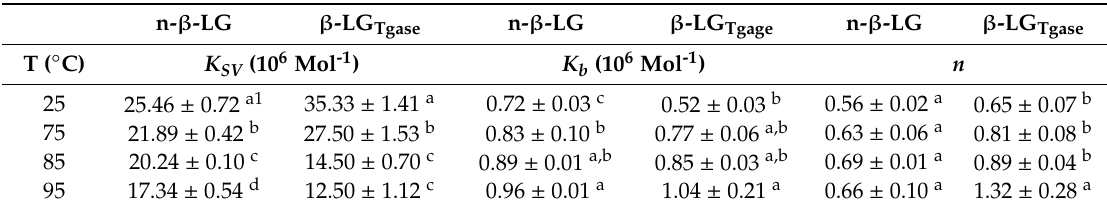
Table 1. Binding parameters between β -LG in native and cross-linked states and ca ff eic acid at di ff erent temperatures.